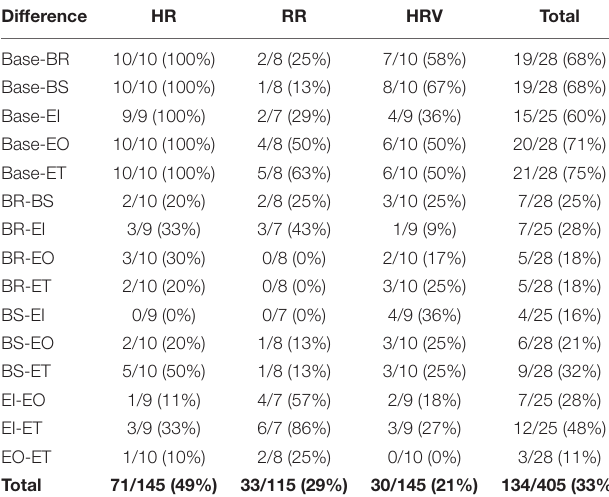
TABLE 8 | Number of statistically significant differences detected per parameter (Hill,